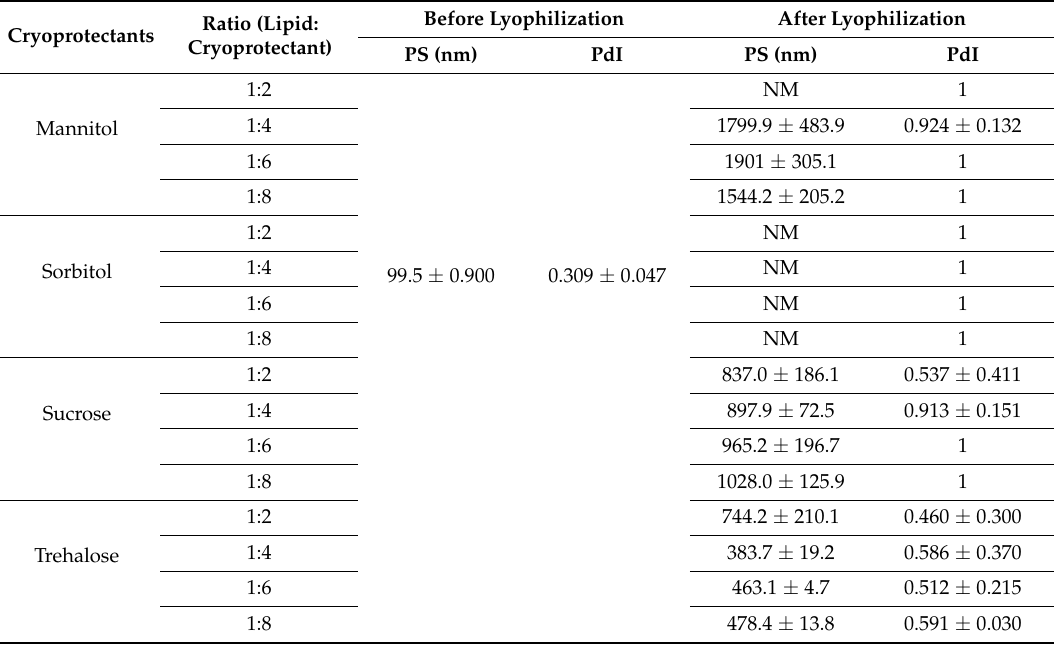
Table 4. Screening of